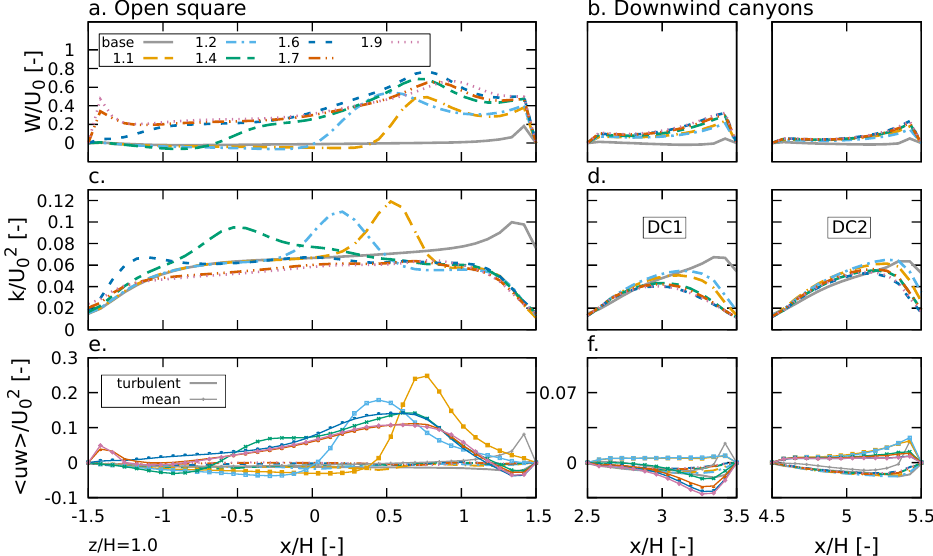
Figure 20. Profiles of non-dimensional ( a , b ) vertical velocity ( W / U 0 ); ( c , d ) TKE ( k / U 0 2 ); and ( e , f ) ver- tical flux budget ( (cid:104) uw (cid:105) / U 0 2 ) over a horizontal line at roof level ( z / H = 1) across the domain’s centre line ( y / H = 0) for the warm water body cases ( ∆ T = + 2 K) and different shapes. Results for ( a , c , e ) the open square and ( b , d , f ) the downwind canyons. In panels ( e , f ), single lines denote mean values, whilst lines with points denote turbulent